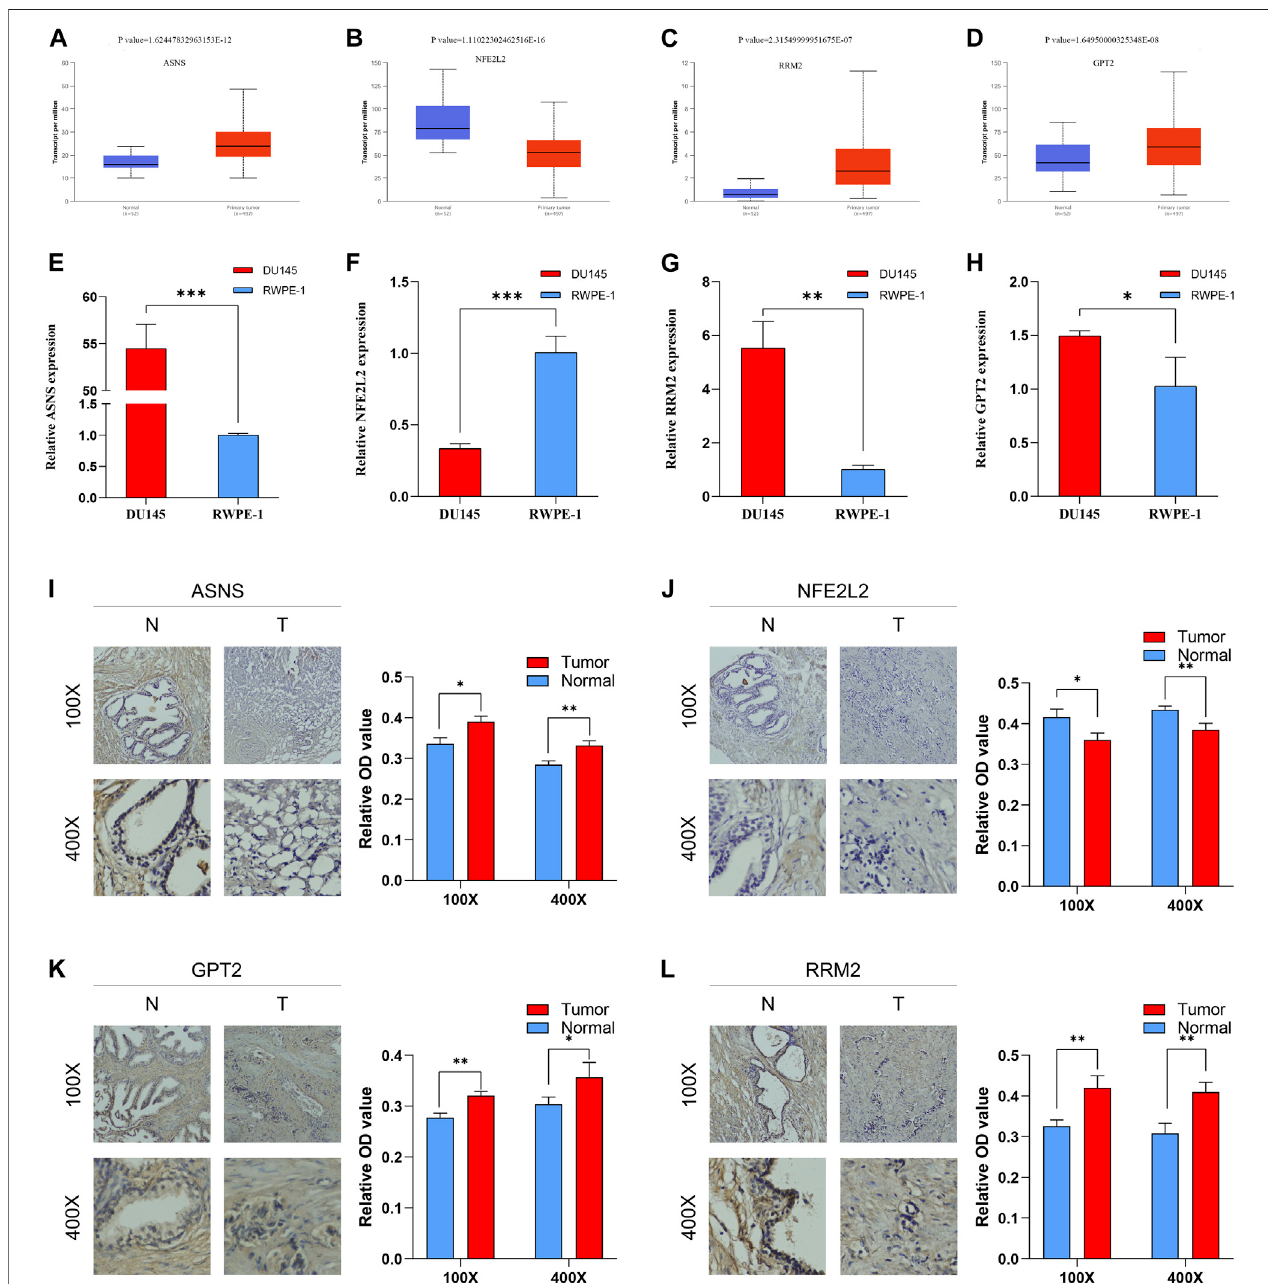
FIGURE 10 | The mRNA expression levels between PCa tissue and BPH tissue of ASNS (A) , NFE2L2 (B) , RRM2 (C) and GPT2 (D) . The mRNA expression levels between PCa cells and normal prostatic epithelial cells of ASNS (E) , NFE2L2 (F) , RRM2 (G) and GPT2 (H) . The protein expression levels between BPH tissue and PCa tissue of ASNS (I) , NFE2L2 (J) , GPT2 (K) , RRM2 (L) . * p < 0.05; ** p < 0.01; *** p < 0.001.